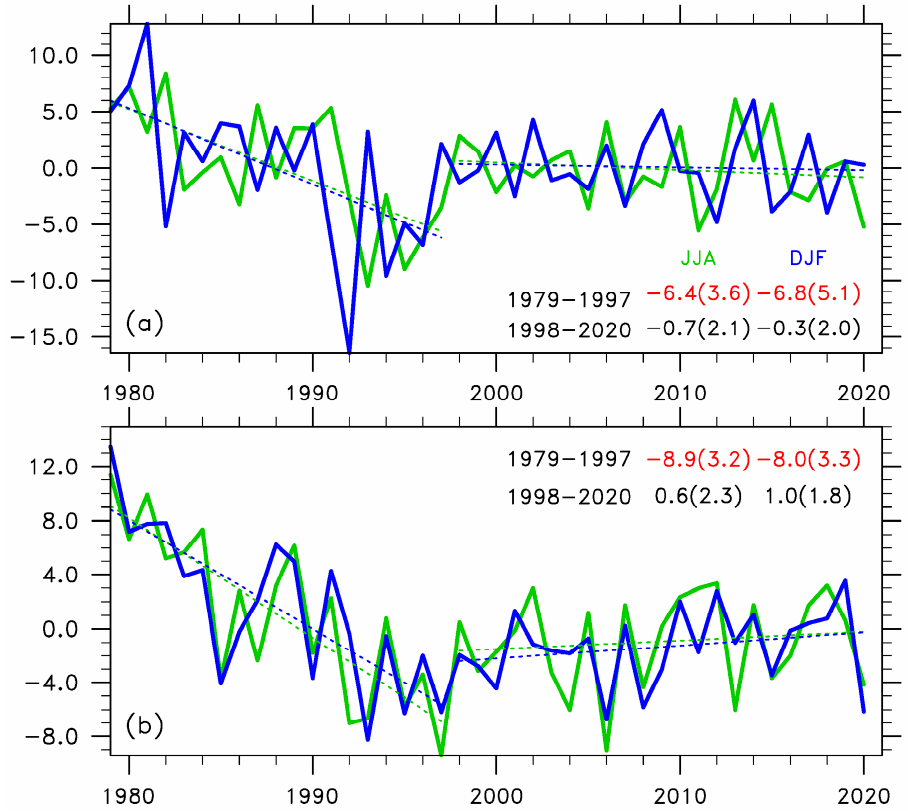
Figure 1. Time series of total column ozone anomalies over 1979–2020 in the ( a ) NH and ( b ) SH. The red and blue lines represent total column ozone averaged in JJA and DJF, respectively. The units are Dobson Unit (DU). The dotted lines indicate the linear regression over 1979–1997 and 1998–2020. The linear trends in JJA and DJF over 1979–1997 and 1998–2020 are marked in the upper right of each panel. Red and black values are statistically significant and insignificant, respectively, at the 95% confidence level using Student’s t-test, with two σ uncertainties in brackets. The units for the trends are DU/decade.